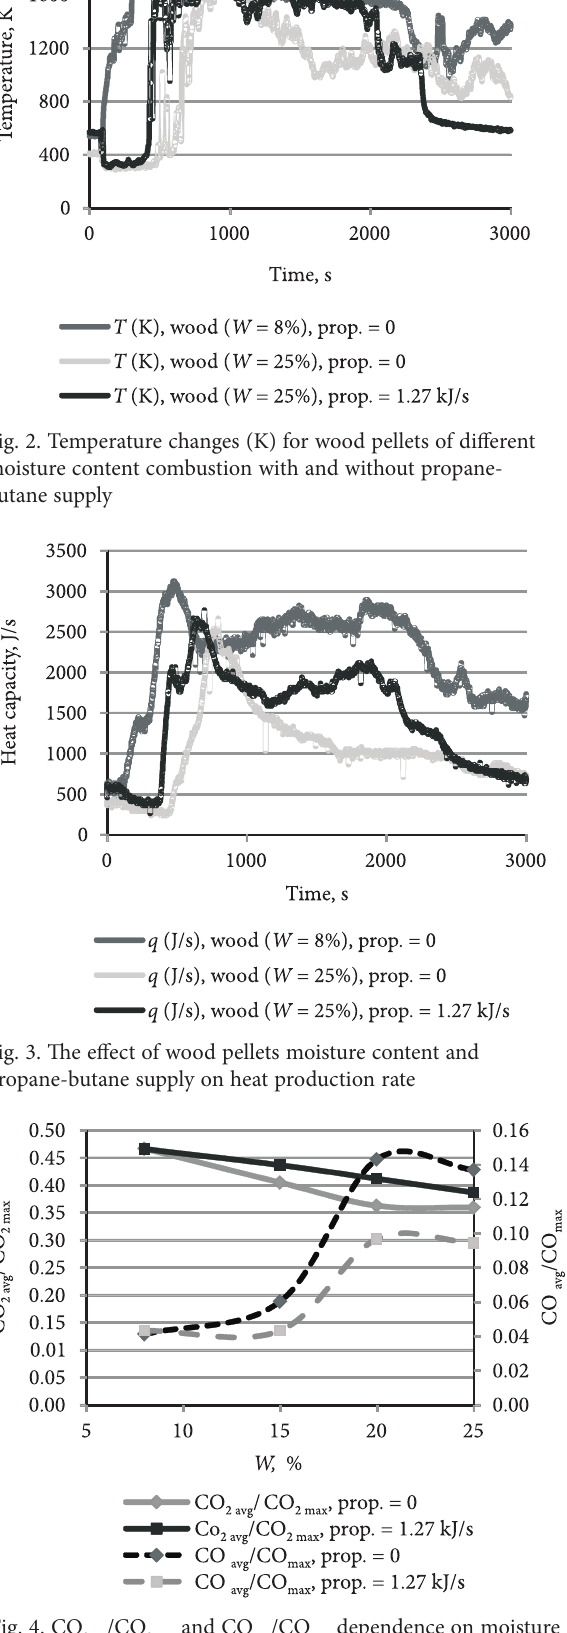
Fig. 4. CO /CO and CO /CO dependence on moisture 2avg 2max avg max content in wood pellets for different combustion